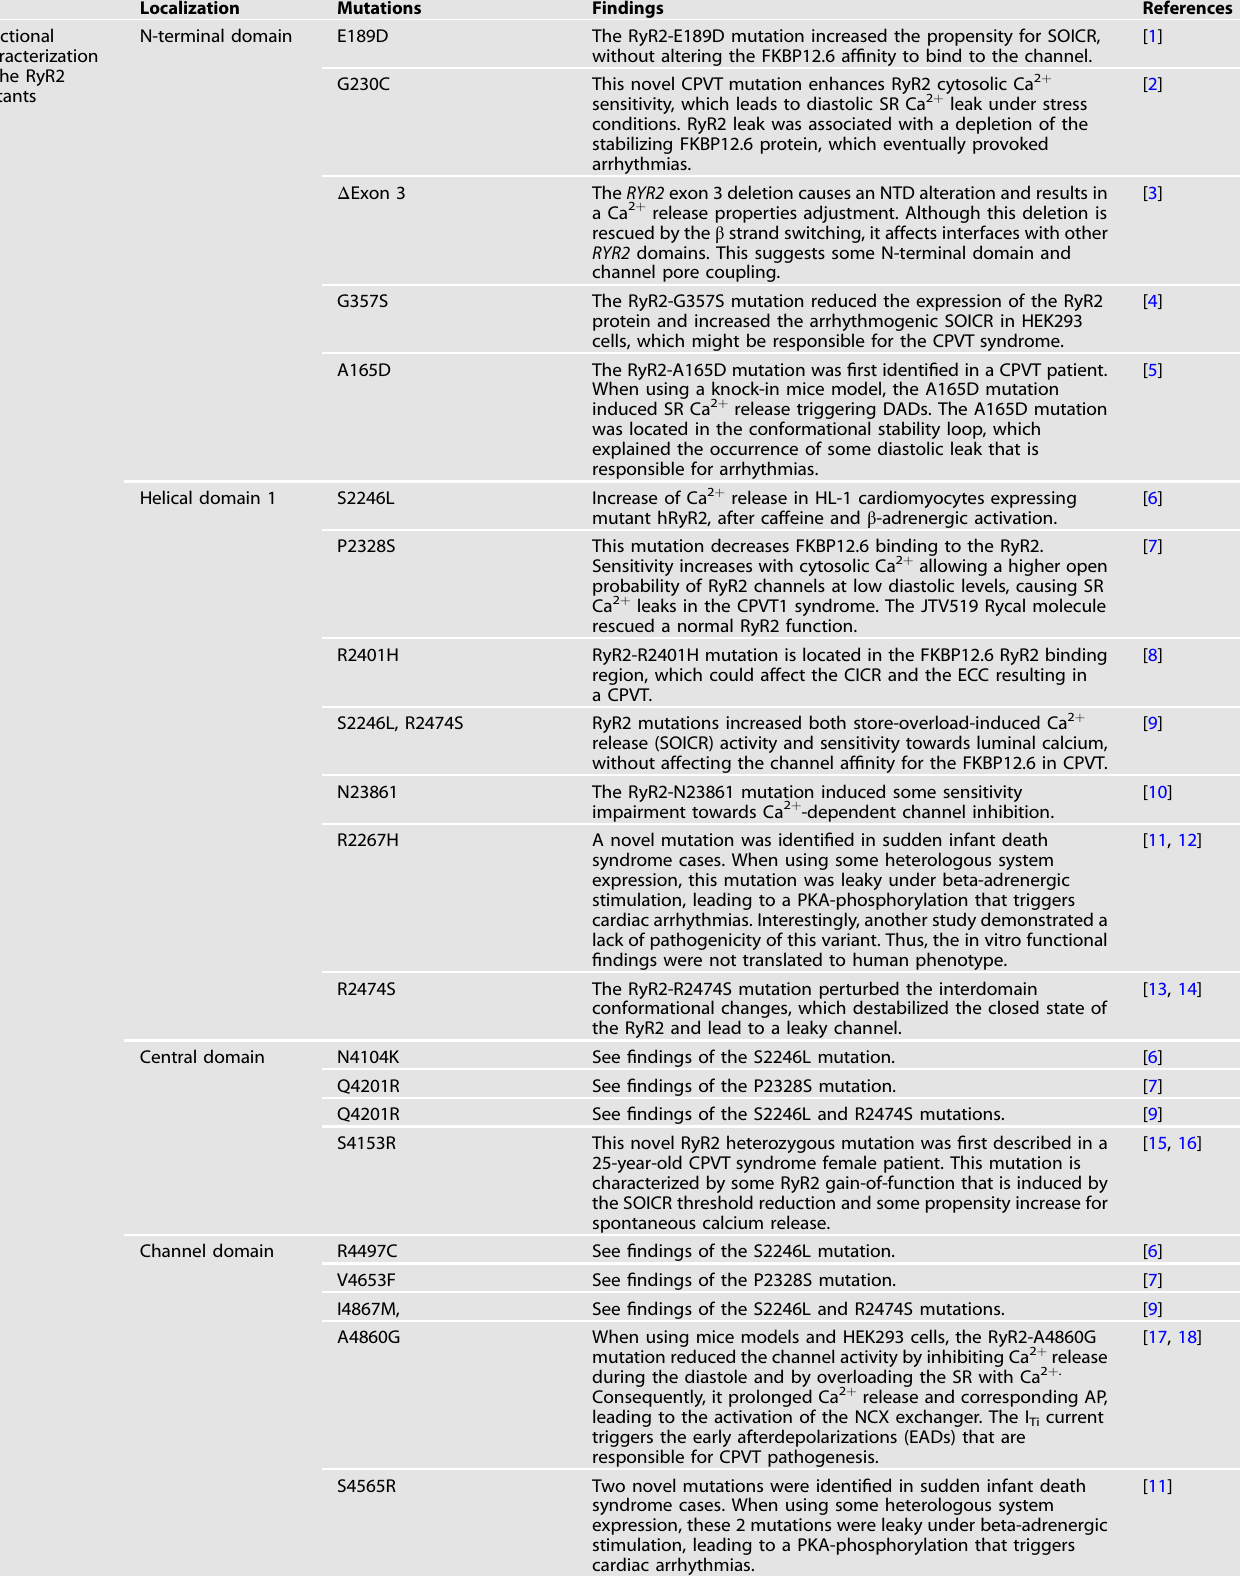
Table 1. List of the RyR2 mutations associated with the CPVT